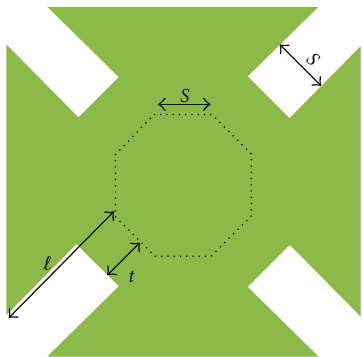
Figure 4: Single cell of the modified Malta